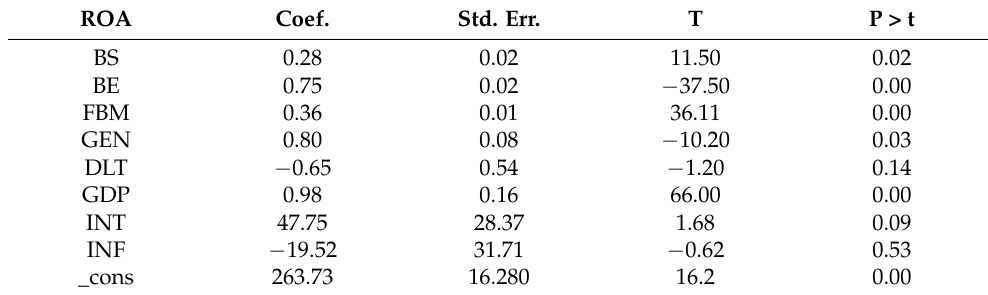
Table 5. Fixed effect panel model.